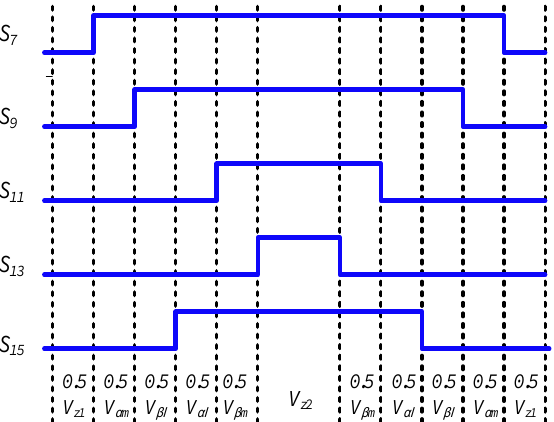
Figure 4. Switching sequence for a five-phase voltage source inverter (VSI) in the first sector.